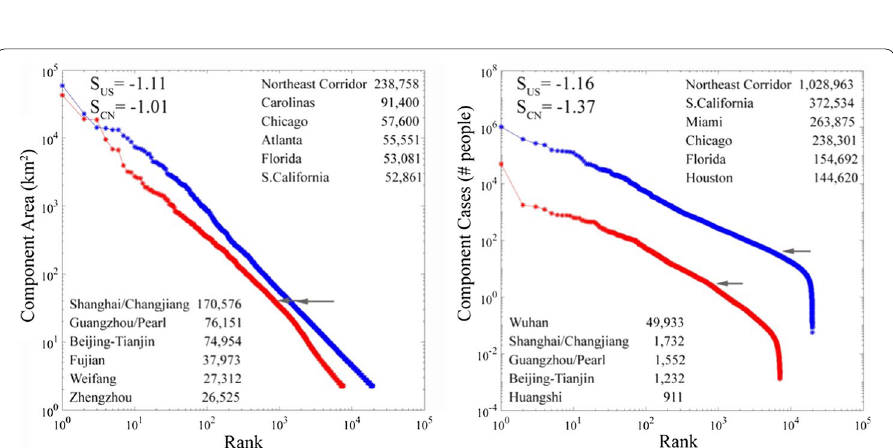
Fig. 9 Rank-size distributions for network component areas and cases. As expected, both China and USA show a near-unity slope scaling of component area and rank, indicating a scale-free tradeoff in component number and area. In contrast, the distributions of component case total and rank are steeper, indicating the relatively greater contribution of larger components with higher density cores and lower contribution of small isolated components. Wuhan has disproportionally more cases than the largest components for obvious reasons, although the low numbers of cases of these largest components fall well below the number expected if the scaling were linear as it is in the